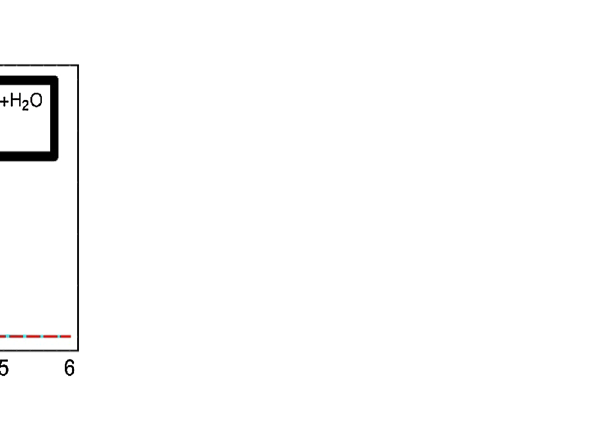
Figure 4. The velocity against fw